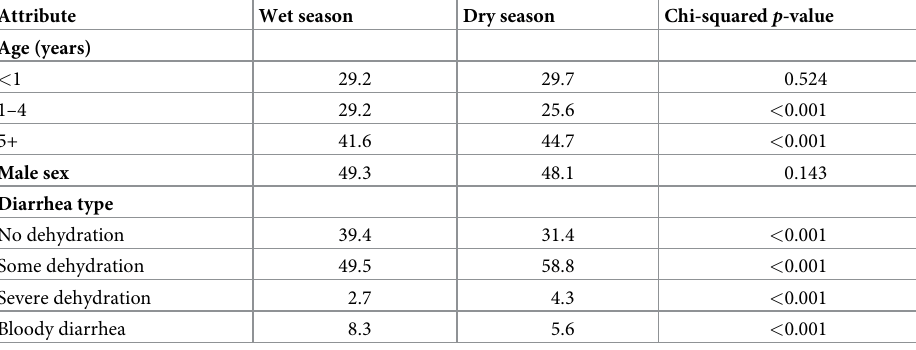
Table 4. Demographics by season of outpatient diarrhea cases in Chobe District. Attribute